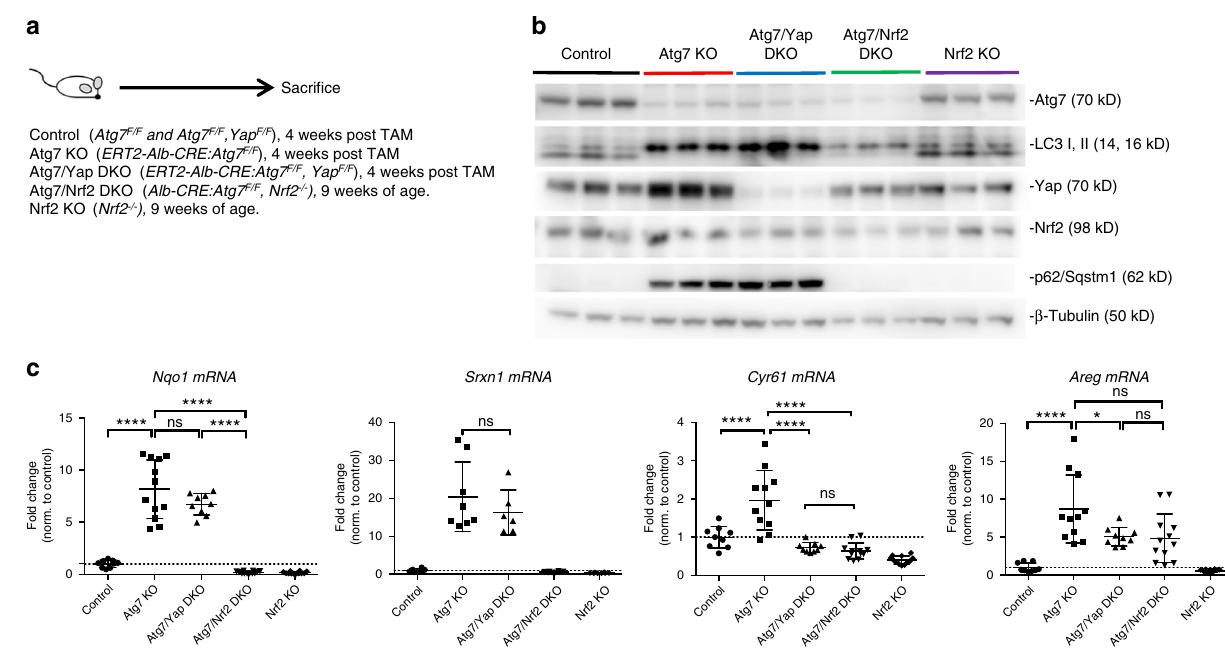
Fig. 4 Intact Nrf2 signaling in Atg7/Yap DKO mice; Atg7/Nrf2 DKO mice do not have evidence of increased Yap activation. a Analysis of control ( Atg7 F/F and Atg7 F/F ,Yap F/F ), Atg7 KO ( ERT2-Alb-CRE:Atg7 F/F ), Atg7/Yap DKO ( ERT2-Alb-CRE:Atg7 F/F , Yap F/F ) 4 weeks post TAM injection, Atg7/Nrf2 DKO ( Alb- CRE:Atg7 F/F , Nrf2 − / − ) and Nrf2 KO (Nrf2 − / − ) at 9 weeks of age. b Immunoblot analysis of whole liver lysate from control, Atg7 KO, Atg7/Yap DKO, Atg7/ Nrf2 DKO, and Nrf2 KO mice. Immunoblotting for Atg7, LC3, Yap, Nrf2, p62/Sqstm1, β -Tubulin. c qRT-PCR analysis of whole liver RNA for Nqo , Srxn1, Cyr61 , Areg . Data normalized to β -actin expression and fold control. Data from 3 ( Cyr61 , Nqo , Areg ) and 2 ( Srxn1 ) independent experiments, respectively. N = 3 – 4 animals per group. Mean ± SD. **** P < 0.0001 as determined by one-way ANOVA and Tukey ’ s HSD test. ns, not signi fi cant. Data represent mean ± SD. P -values analyzed by one-way ANOVA and Tukey ’ s HSD. * P < 0.05, ** P < 0.005, *** P < 0.001, **** P < 0.0001 unless indicated